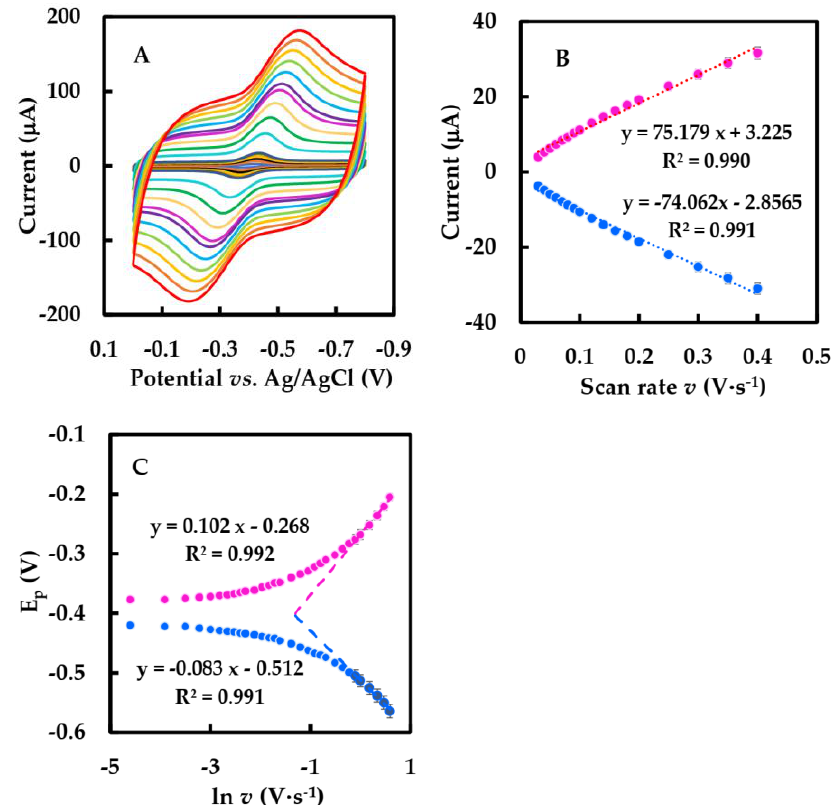
Figure 5. ( A ) CVs of the NF-GLA/MWCNTs-BSA-HFs-GOD/GCE in N 2 -saturated 50 mM phosphate-buffered solution (pH 6) at different scan rates (from inner to outer): 0.01, 0.02, 0.03, … 1.8, 2 V ‧ s −1 , respectively. ( B ) The relationship of the scan rates (0.03 – 0.4 V ‧ s −1 ) versus the peak currents. ( C ) The relationship of the peak potential ( Ep ) versus ln v .